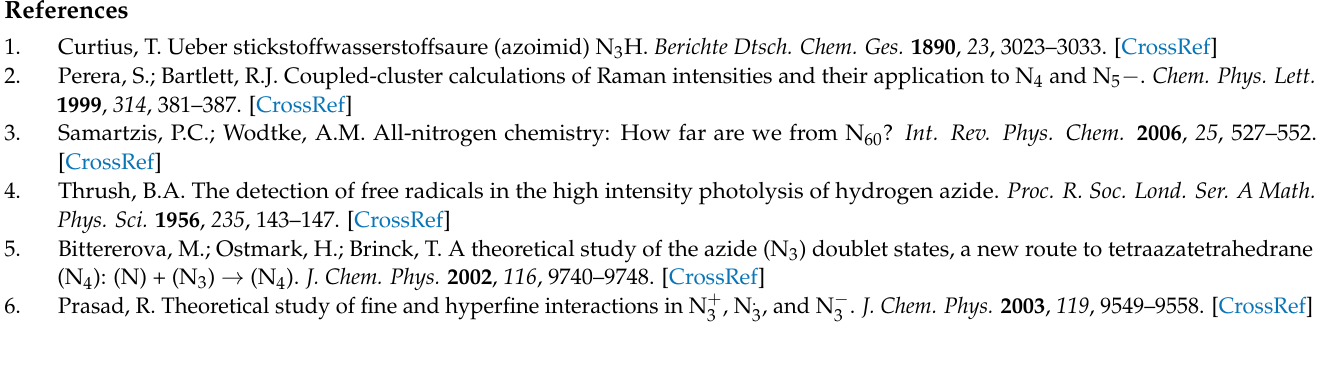
2 (cid:52) 0 is the enthalpy of formation calculated by the atomization f H